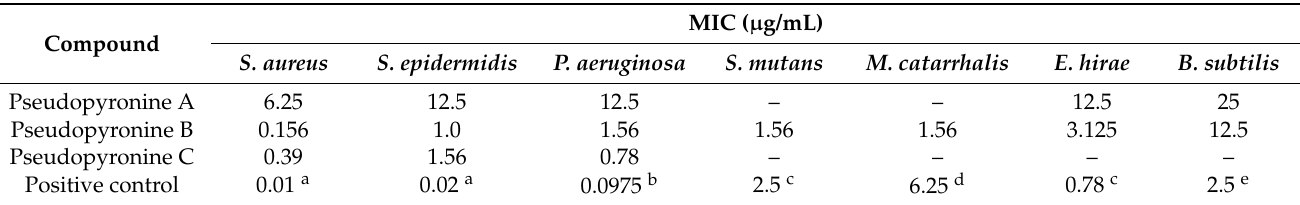
Table 1. MICs of pseudopyronines A, B and C against multiple pathogenic bacteria.